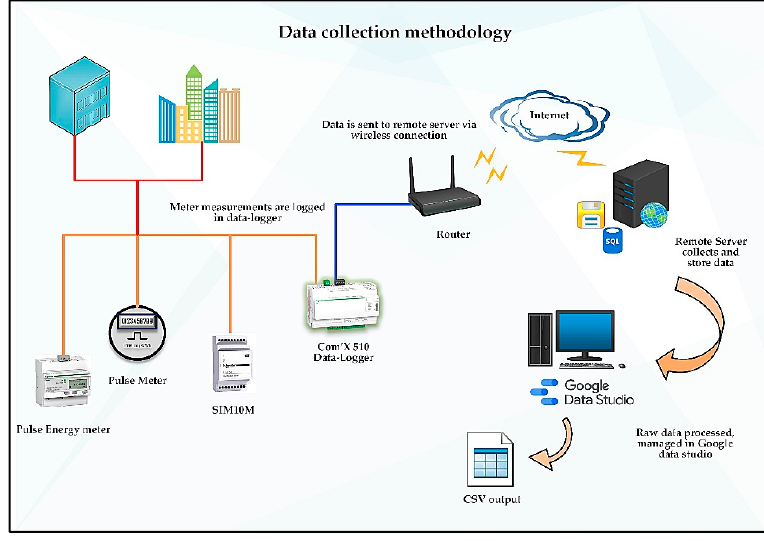
Figure 3. Methodology for data collection (redrawn from [3]).